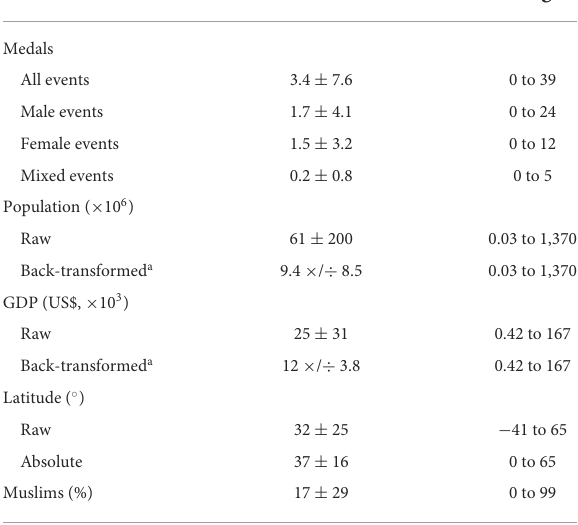
TABLE 2 Descriptive statistics of the 205 nations that attended the Tokyo summer Olympics in 2021. Mean ± SD or Mean × / ÷ SD